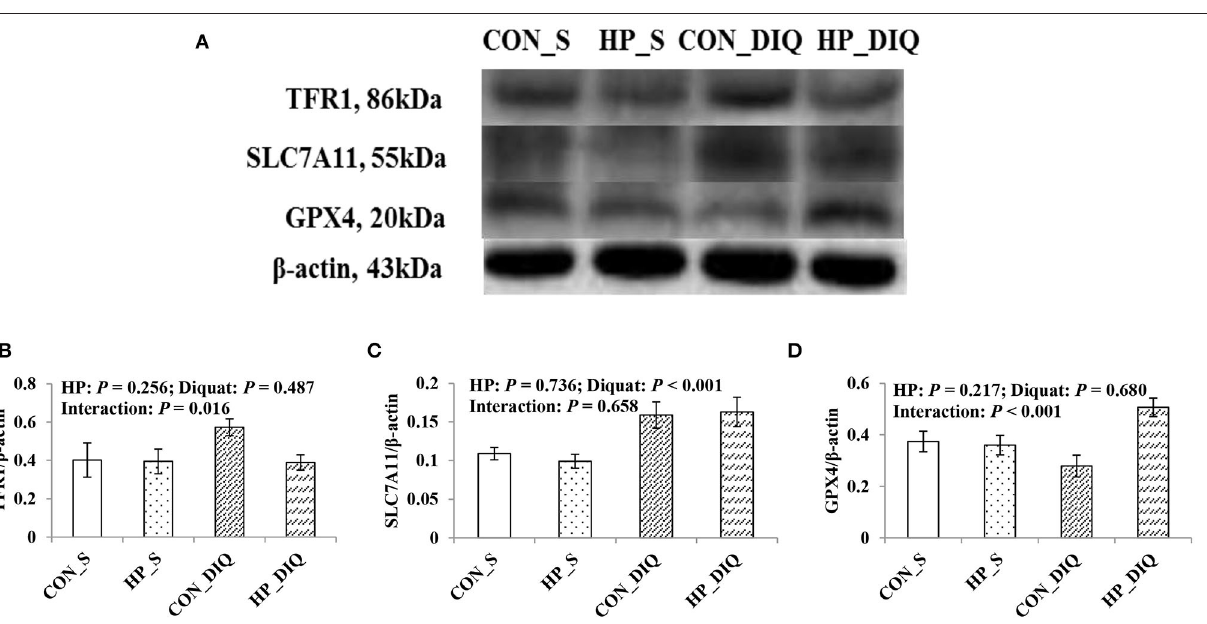
N = 8 (1 pig/pen). SEM, standard error of mean. a , b Labeled means in a row without a common letter differ, P < 0.05. TFR1, transferrin receptor protein 1; HSPB1, heat shock protein beta 1; SLC7A11,